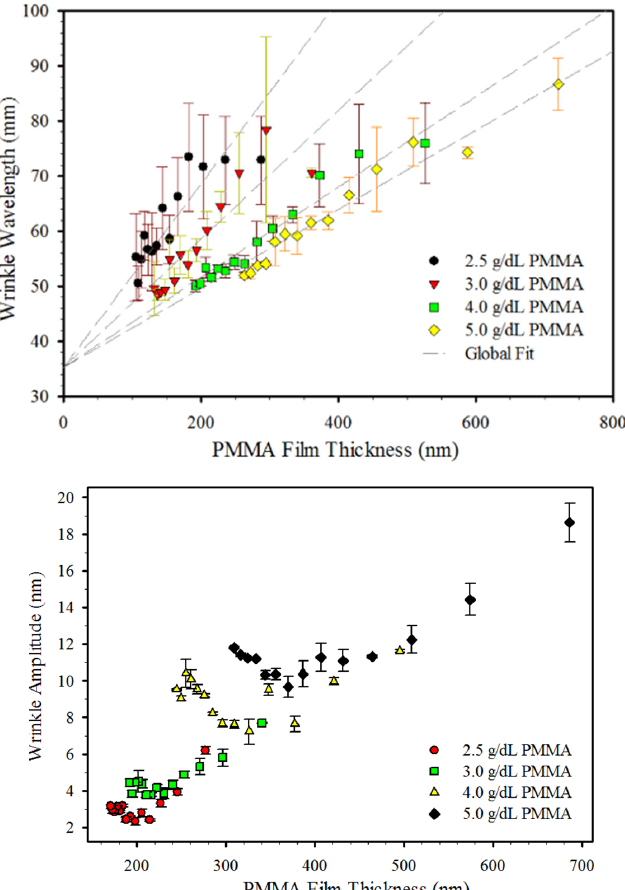
Figure 6. PMMA surface wrinkle wavelength ( A ) and wrinkle amplitude ( B ) as a function of final film thickness. PMMA thin films were cast from 2.5, 3.0, 4.0, and 5.0 g/dL solutions spun at speeds from 400 to 3000 RPM. The error bars represent the standard deviation of at least four different determinations taken at increments of 3.75, 7.50, 11.25, and 15.00 mm from the center of each